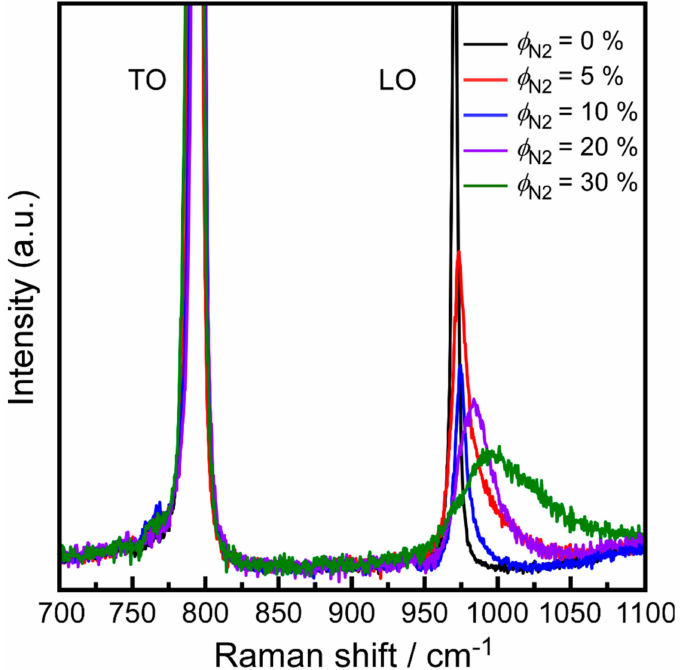
Figure 5. Raman spectra of N-doped 3C-SiC bulks grown with di ff erent φ N2